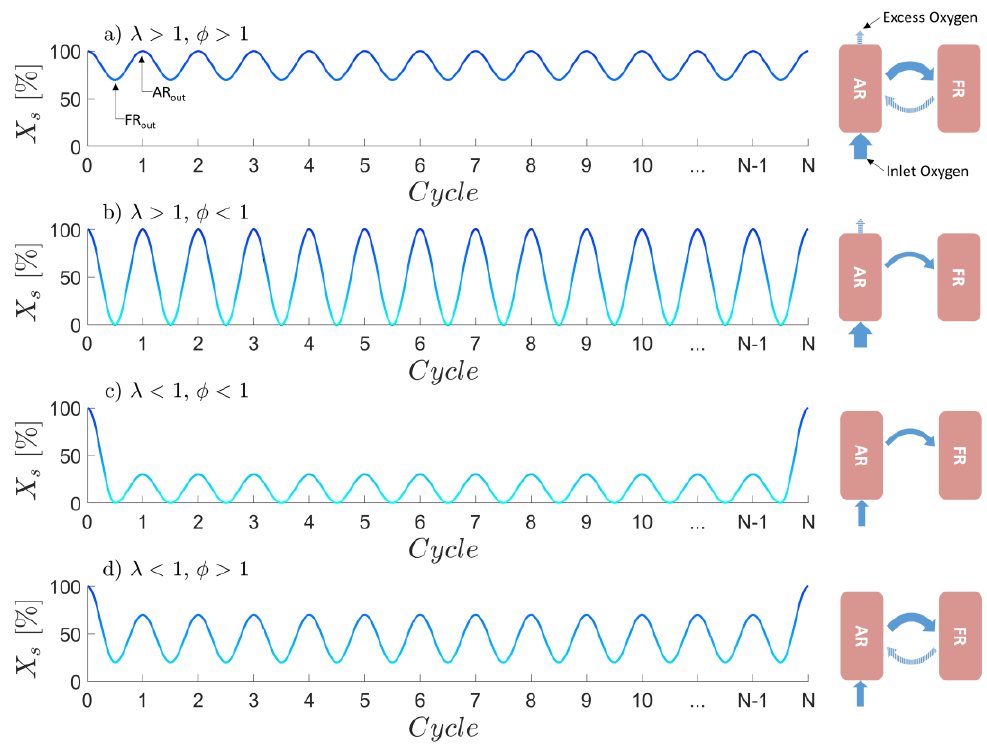
Figure 3. Different chemical looping modes ( a – d ) dependent on the air-to-fuel equivalence ratio 𝜆 and the oxygen-carrier-to-fuel equivalence ratio 𝜙 .